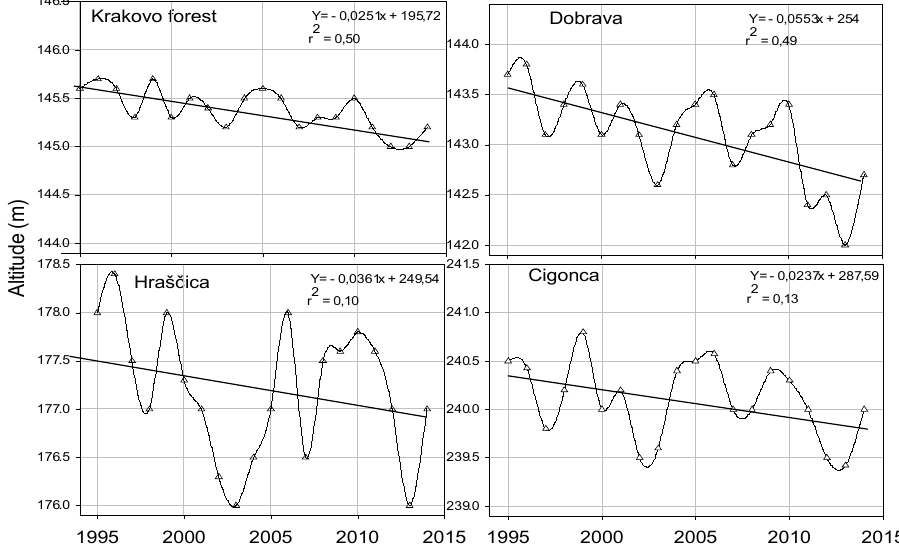
Figure 4. Dynamics of groundwater table for observed forest complex-the mean annual value for the closest measuring station is provided.